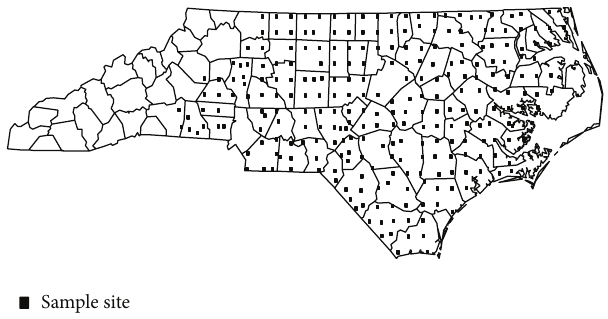
Figure 1: Sample sites for the 2010 survey of North